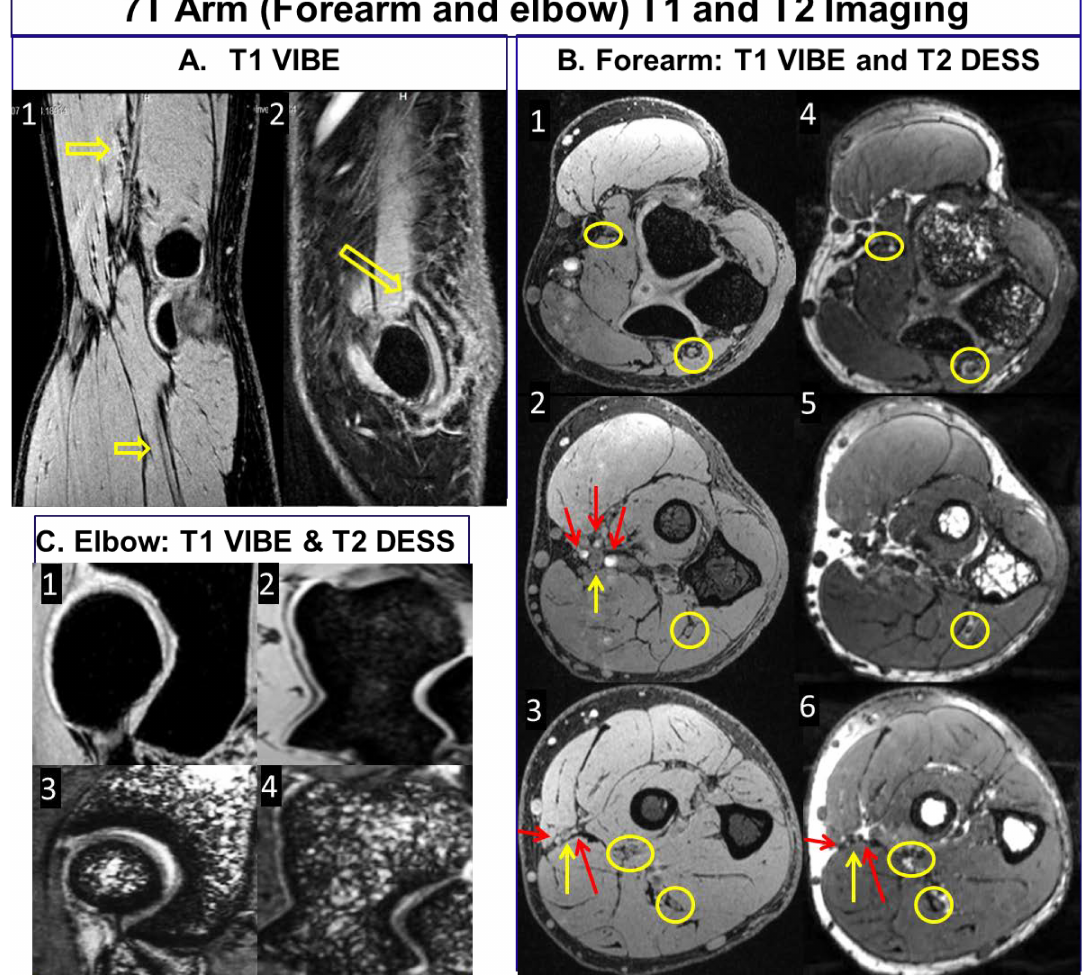
Fig 5. 7T T1 VIBE and T2 DESS: A1 [T1 VIBE] representsradial and median nerve delineation [arrows]; A2 [T2 DESS] shows ulnar nerve [arrow]; B:1–3 [T1 VIBE] and corresponding T2 DESS [B:4–6] show three axial slices [close to elbow, forearm, and close to wrist] that depict radial, median and ulnar nerves [yellow arrows, circles] in additionto the major arteries [red arrows]; Note that there are motion and pulsatileflow artifacts [band of bright points] from median artery in anterior to posterior phase encoding direction; C:1–2 [T1 VIBE] and C:3–4 [T2 DESS] show joint anatomydepictingbone, cartilage, and synovial fluid.